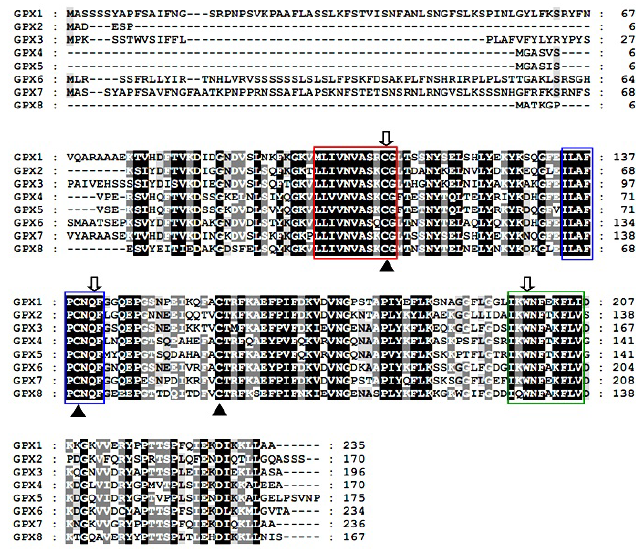
Figure 2. Amino acid sequences of Thellungiella salsuginea glutathione peroxidase (TsGPX) proteins. The conserved three Cys residues of plant GPX proteins are indicated by triangles. Boxed sequences represent highly conserved domains in which residues forming a catalytic triad in GPX are marked with an arrow.